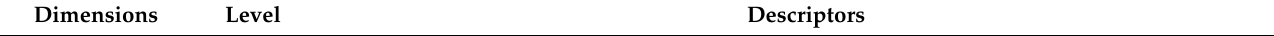
Table 1. Category system for the learning to learn competence. Own elaboration based on the European Commission [68].